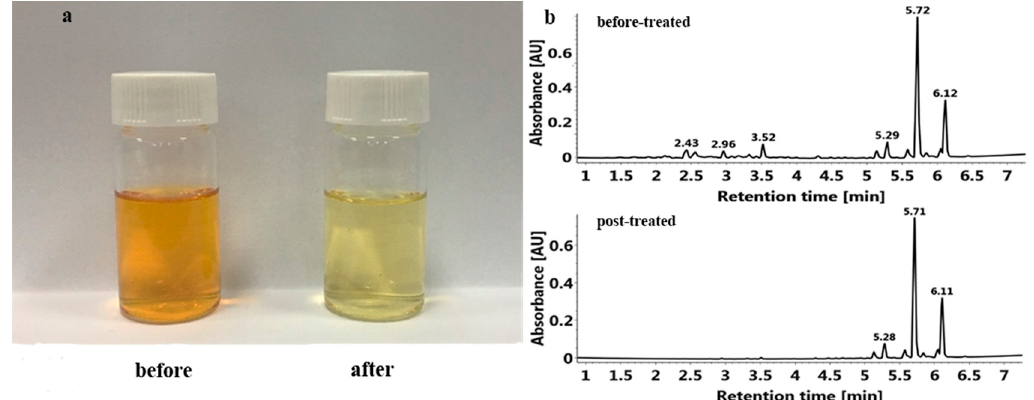
Figure 4. Effects of before- and post-enrichment on PMF extraction. ( a ) PMF extract solution before and after purification by HPD 300 resin; ( b ) Effects of HPD 300 resin on UPLC spectrum of PMFs extract.